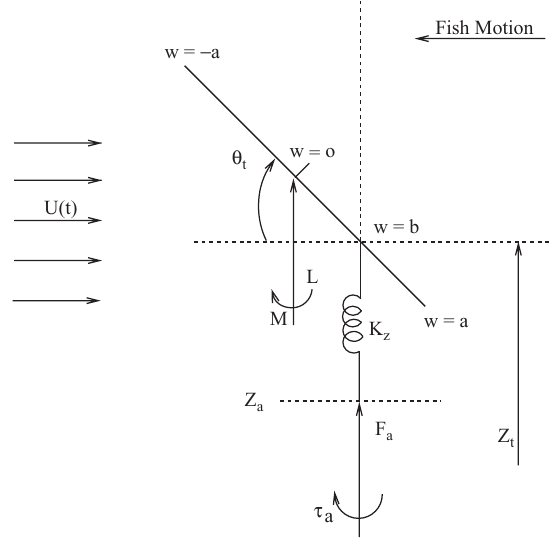
Figure 1 Spring-driven